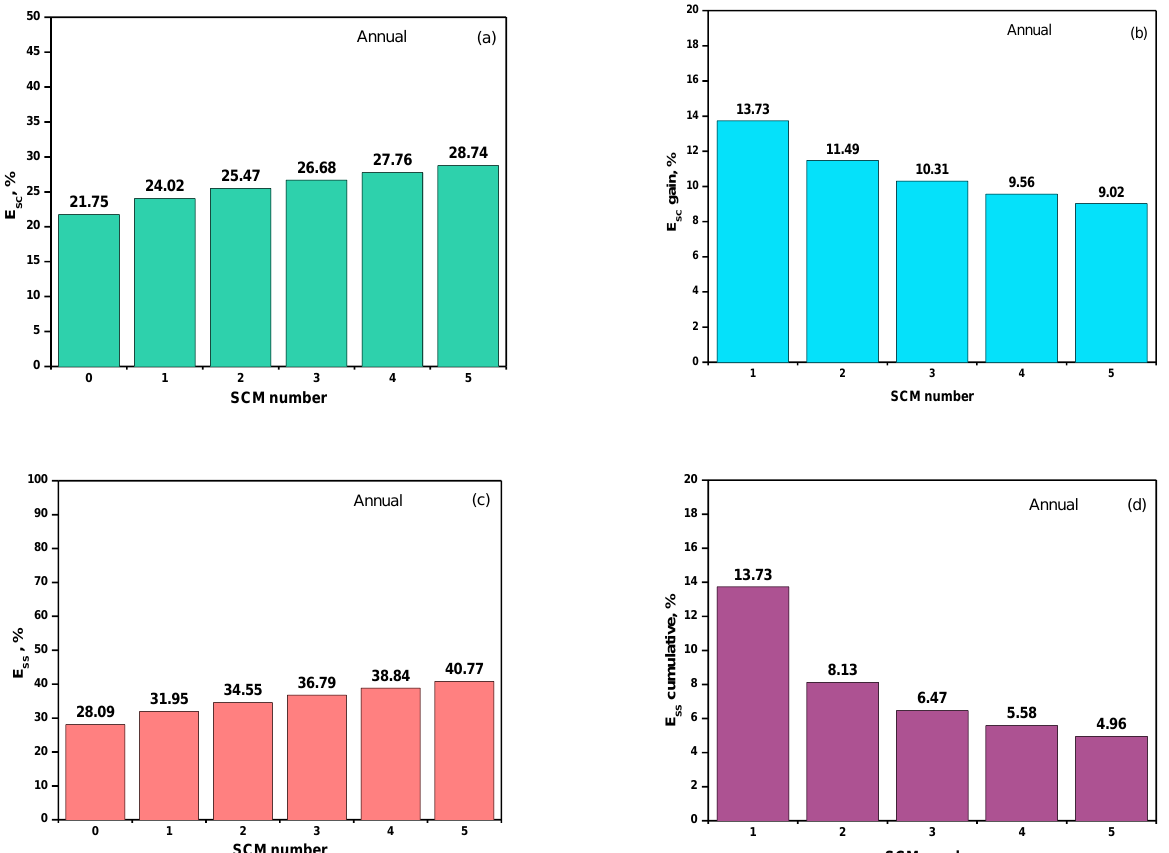
Figure 11. Annual E SC percentage ( a ), E SC gain ( b ), E SS percentage ( c ), and cumulative E SS ( d ).